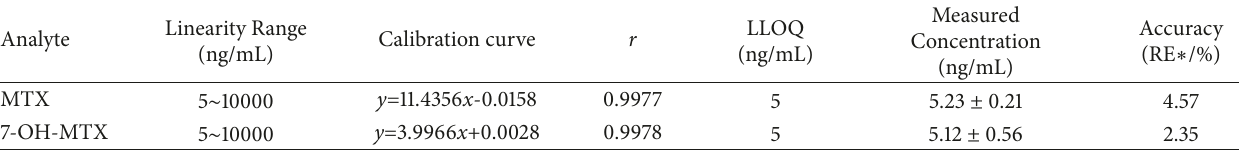
Table 2: Linearity regression parameters for MTX and 7-OH-MTX (n=5). Analyte